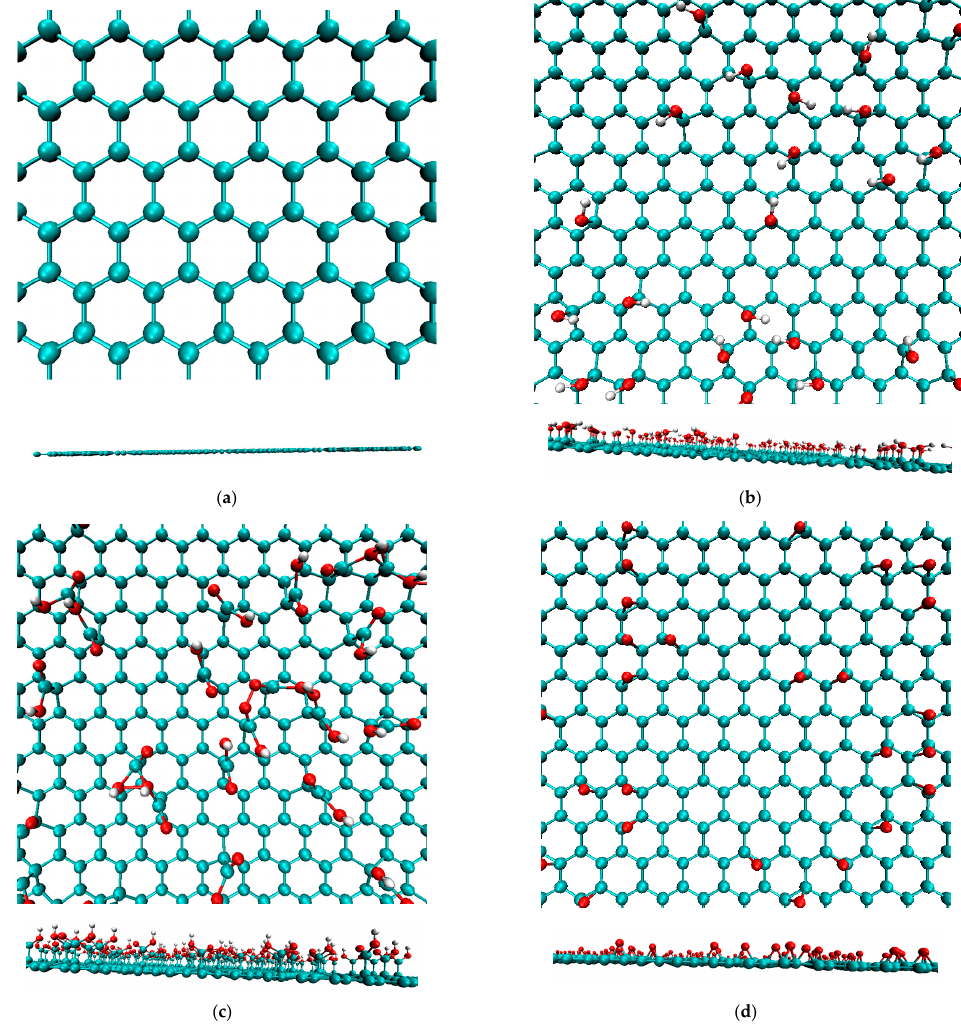
Figure 1. Snapshots of graphene sheets with and without functionalized groups. The upper and lower figures represent the top and side views, respectively. ( a ) Without functional group. ( b ) With functional group –OH. ( c ) With functional group –COOH. ( d ) With functional group –O–.